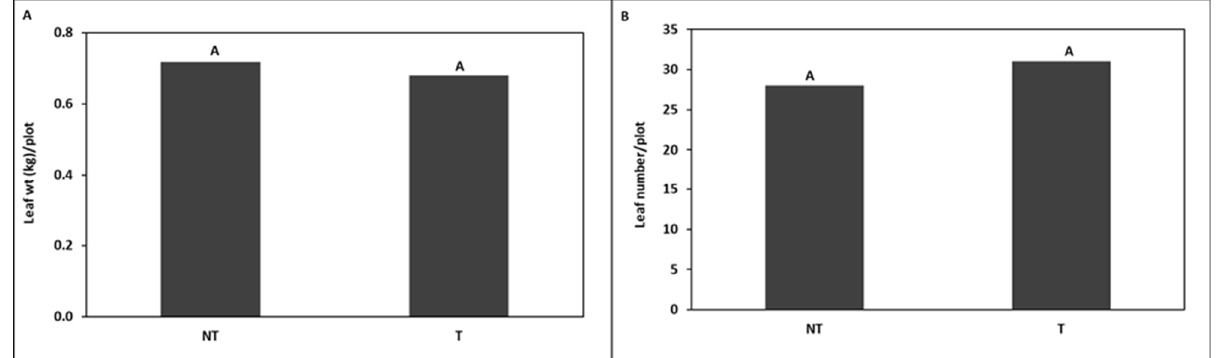
Figure 17. Effect of trap cropping on ( A ) leaf weight; and ( B ) number of leaves of kale in Trial II. Means followed by the same letters in a graph are not different based on analysis of